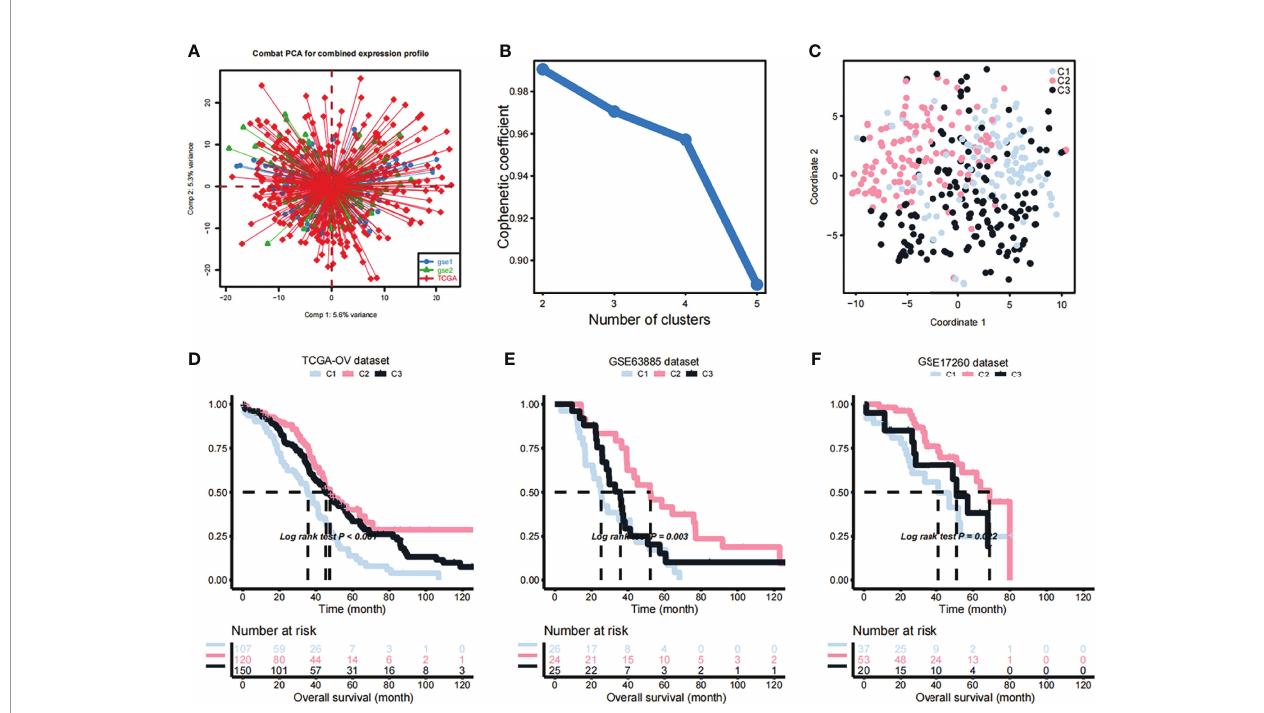
FIGURE 1 | Identi fi cation of OV subtypes based on metabolic genes. (A) Combat principal component analysis (PCA) was performed to identify the distribution of the expression pro fi les of genes in the dataset merged TCGA and 2752 metabolism-related genes. (B) Cophenetic plot indicating the cophenetic coef fi cient in function of the number of cluster components. (C) Two-dimensional t-SNE distribution pattern distribution in the identi fi ed subtypes. (D) Differences in the survival probabilities of patients in the identi fi ed subtypes based on the TCGA dataset. (E) Differences in the survival probabilities of patients in the identi fi ed subtypes based on the GSE63885 dataset. (F) Differences in the survival probabilities of patients in the identi fi ed subtypes based on the GSE17260